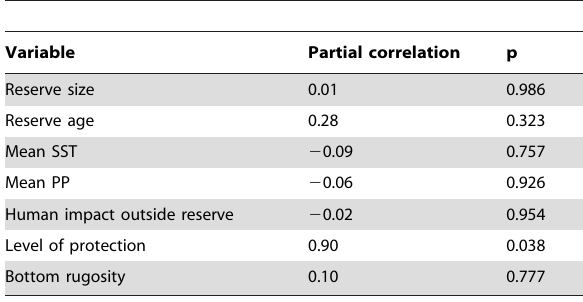
Table 4. Results of multiple linear regression on total fish biomass in the studied marine protected